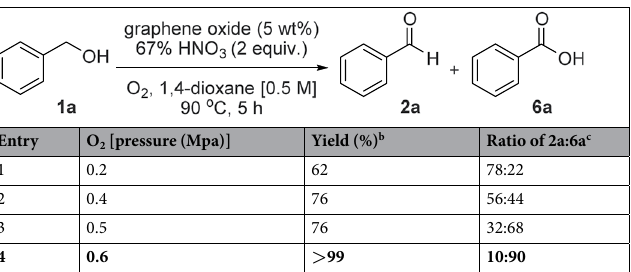
Table 3. Optimization of the reaction conditions for the graphene oxide-catalyzed oxidation of benzyl alcohol to carboxylic acid with HNO 3 under variation of oxygen pressure a . a Reaction conditions: 1a (1 mmol),